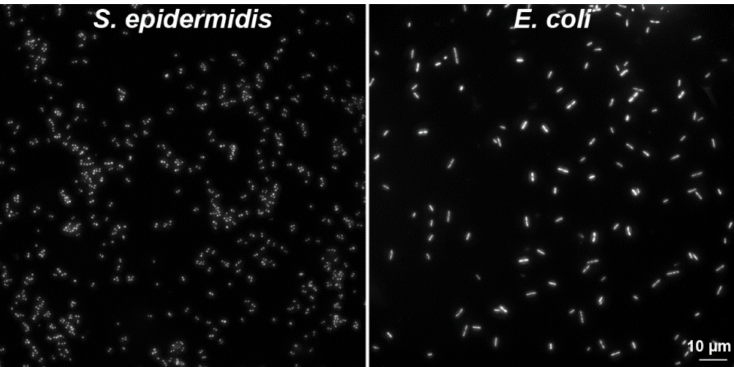
Figure 9. Examples of captured bacteria strains. E. coli and S. epidermidis were deposited on the glass coverslips by CytoTrap, fixed by formaldehyde, permeabilized by Triton X-100, and the bacterial DNA was stained by DAPI. Scale bar = 10 µ